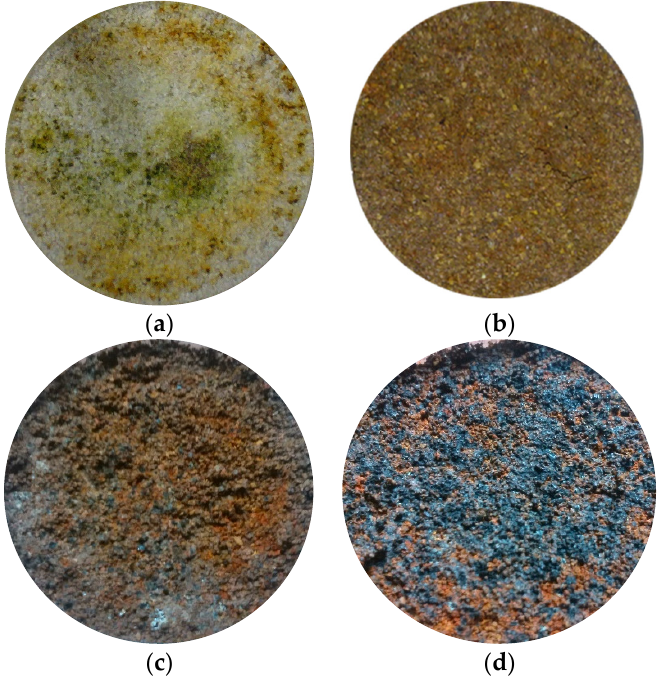
Figure 8. Photos of the inlet section of the column at the end of the column tests for different test conditions. ( a ) ZVI/pumice (w.r. 30:70) Ni 95 mg/L Q = 2.5 mL/min Kr = 0.932. ( b ) ZVI/lapillus (w.r. 30:70) Ni 100 mg/L Q = 0.5 mL/min Kr = 0.857. ( c ) ZVI/lapillus (w.r. 50:50) Zn 50 mg/L Q = 0.5 mL/min Kr = 0.107. ( d ) ZVI/lapillus (w.r. 30:70) Ni 10 mg/L Q = 0.5 mL/min Kr = 0.0041.